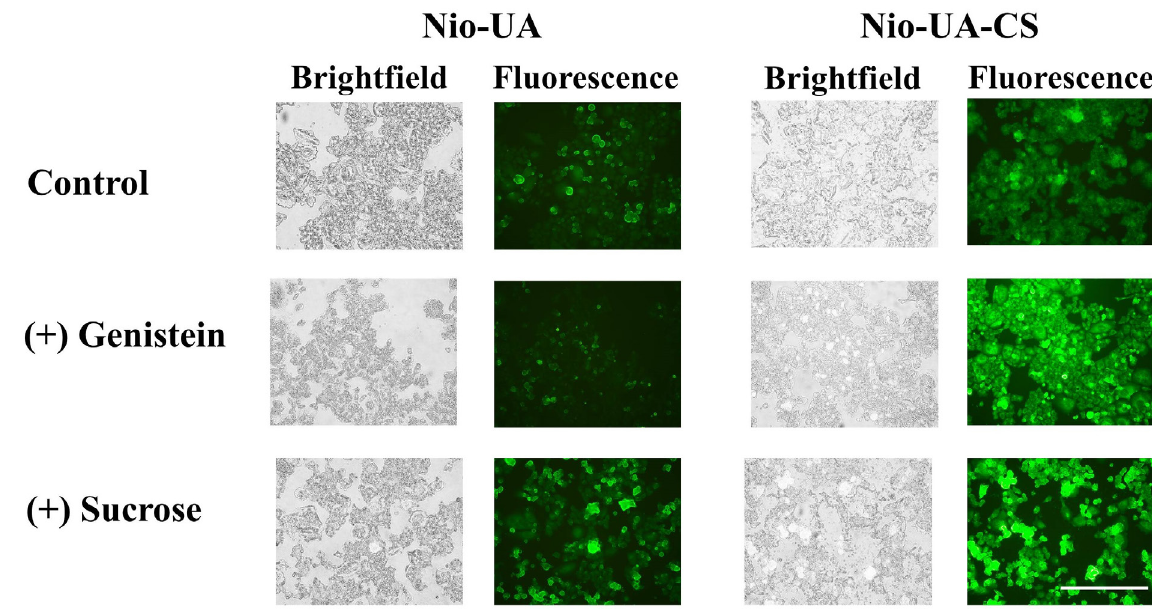
Figure 2. Photomicrographs of cellular uptake of HeLa cells after incubated with Nio-UA and Nio-UA-CS containing Coumarin-6 for two hours without and with addition of genistein and sucrose pre-treatment. Scale bar= 100